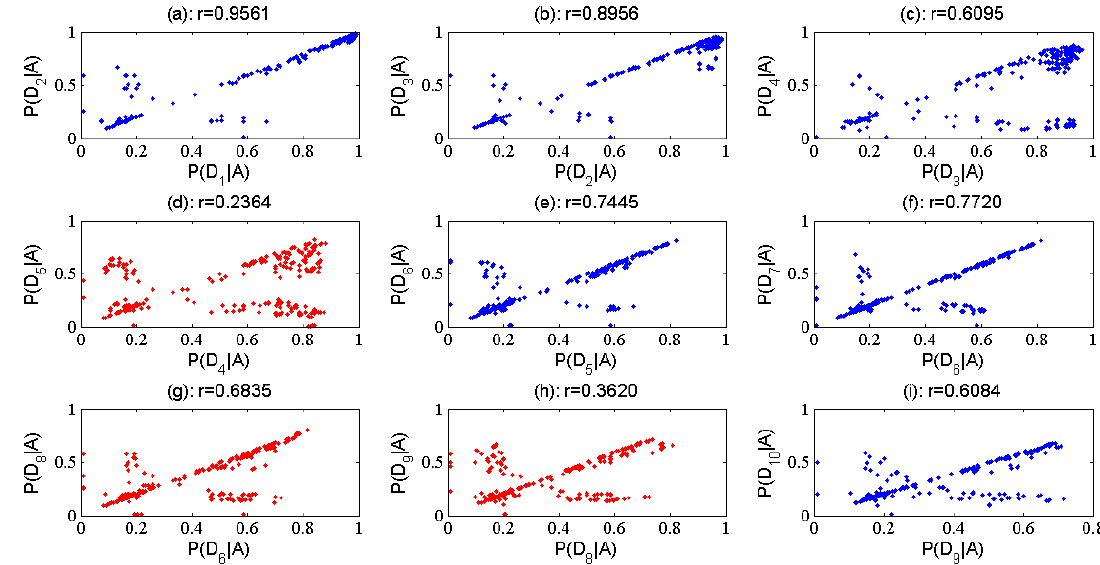
Figure 6. Maximum correlation coefficients between various transition probabilities. Table 2. Training weights of MANN with interaction noise. Input node, hidden nodes and output node are represented by i, h1 to h3 and o, respectively; b1 and b2 are the bias nodes in the hidden layers.